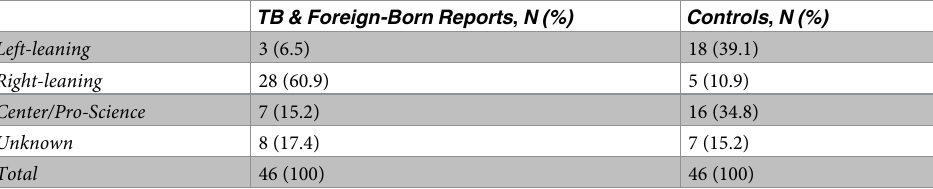
Table 1. Report count categorized by political